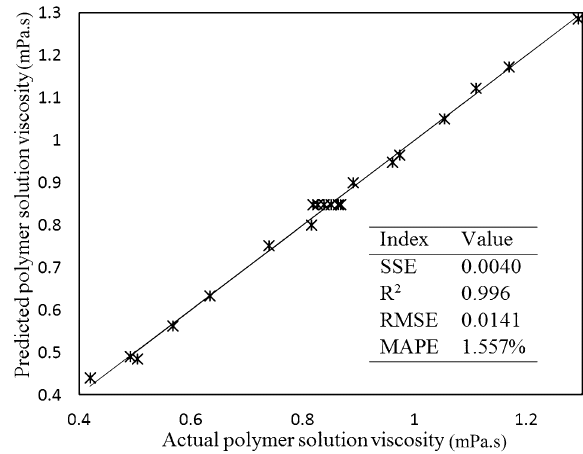
Fig. 2 Comparison between the polymer solution viscosity predicted by RSM model and the experimentally determined viscosity (response data have been transformed using base 10